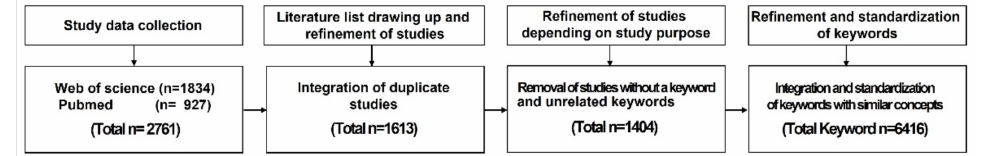
Figure 1. Study data